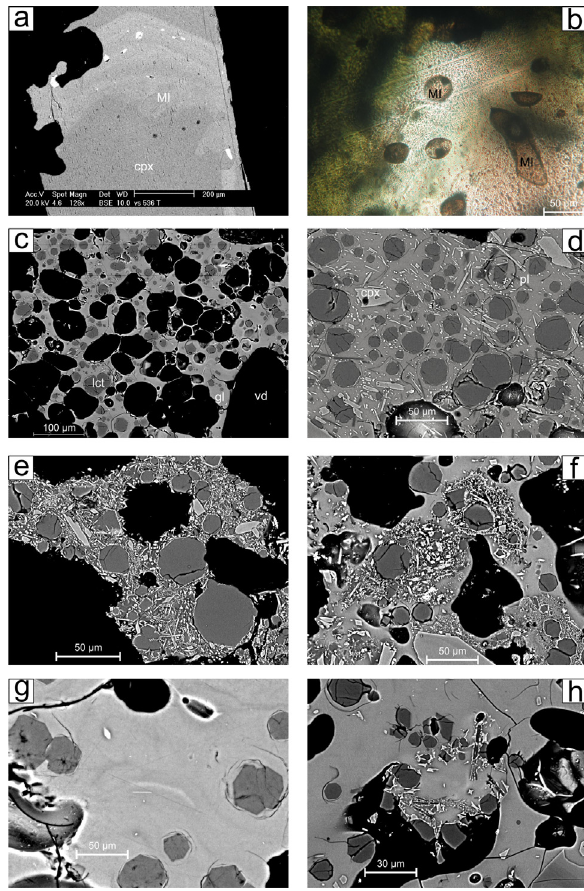
Figure 6. A random selection of about 30 fragments for sample, in the size 1 U and 3 U size intervals, was considered for the petrograph- ical characterization (vesicularity, crystal-content, texture). Backscat- tered (BSE) images were captured with scanning electron microscopy (SEM) at Istituto Nazionale di Geofisica e Vulcanologia (Pisa) using a Zeiss EVO-MA-10 working at accelerating voltage 15 kV and distance 10 mm. a) BSE image of a pyroxene phenocryst characterized by a large, resorbed core and complex oscillatory rim. Trapped melt in- clusions are visible at the border between the core and rim; b) optical microscope image of pyroxene phenocryst with many brown, round melt inclusions. c-d-e-f-g-h represent BSE images, showing the main textural features of: c) a vesicular, glassy ash fragment from the VSM5 sample; d) a low vesicular, intermediate crystal-rich ash frag- ment from VSM 5 sample; e) dense, crystal rich fragment from VSM11 sample; f) dense, crystal rich portion of clasts included in a glassy groundmass; g) chaotic texture of two glasses with different composition in VSM 5 sample; h) two glasses with different com- positions separated by quenching microlites. cpx, clinopyroxene; MI, melt inclusion; V, vesicles; gl, glass; lct, leucite; pl,